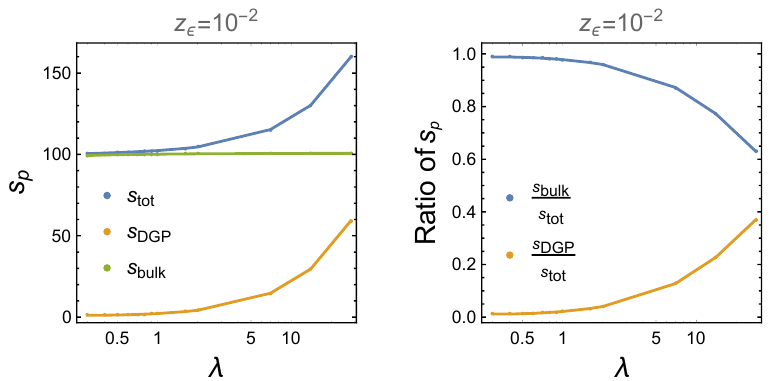
Figure 8 . The entanglement entropy density s p and the contributions of each component ( s p ) DGP and ( s ) for different λ , where the UV cut-off is (cid:15) = 0 . 01 p bulk